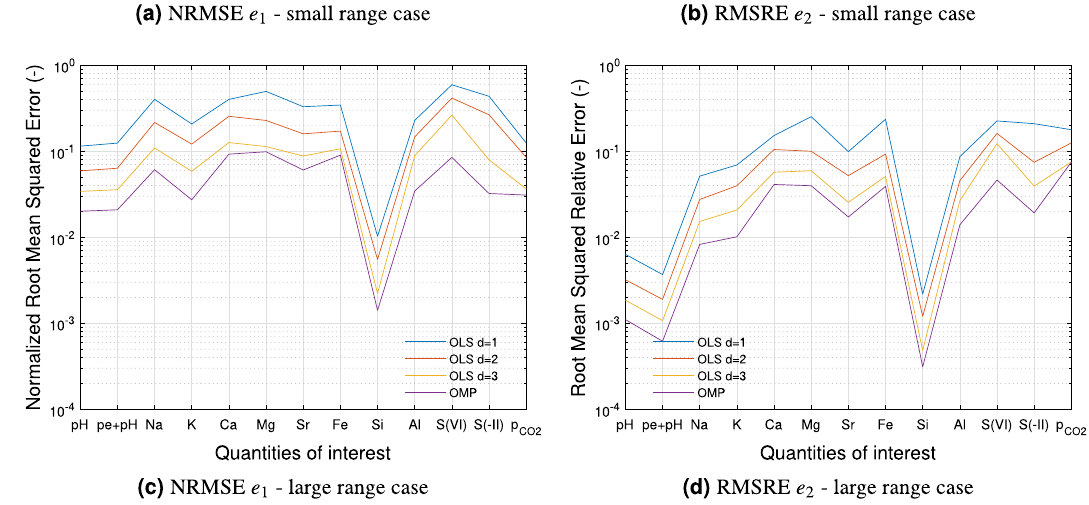
Figure 1. Validation errors for different PC